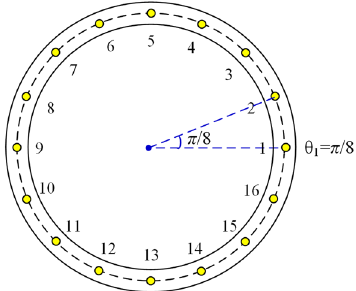
Figure 2 Bolt distribution in the tuned